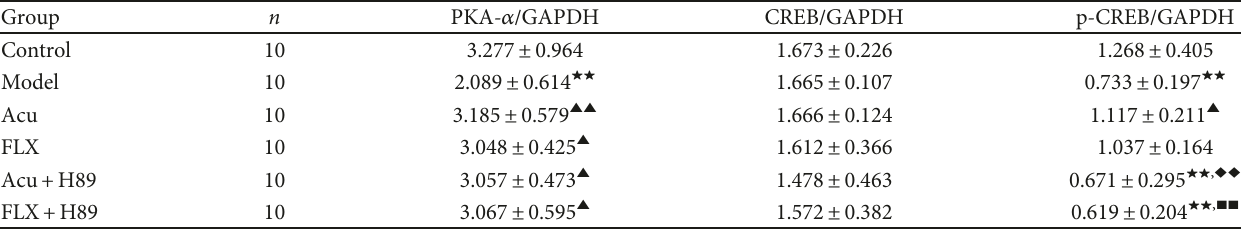
Table 3: Di ff erences showing the e ff ects of stress/antidepressant treatments on the expression levels of hippocampal PKA- α , CREB, and p-CREB in depression rats induced by